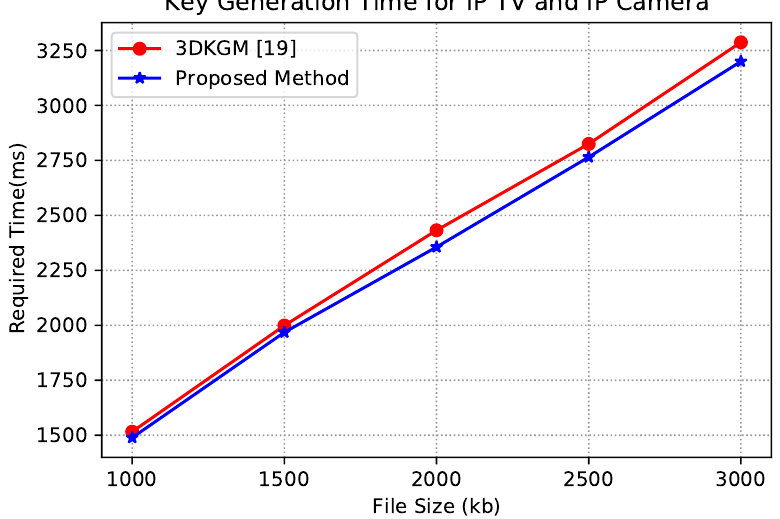
Figure 7. Required time for generating key using 3-dimensional key generation matrix (3DKGM) [6] and the proposed method for the case of IP TV and IP Camera based on Tables 2 and